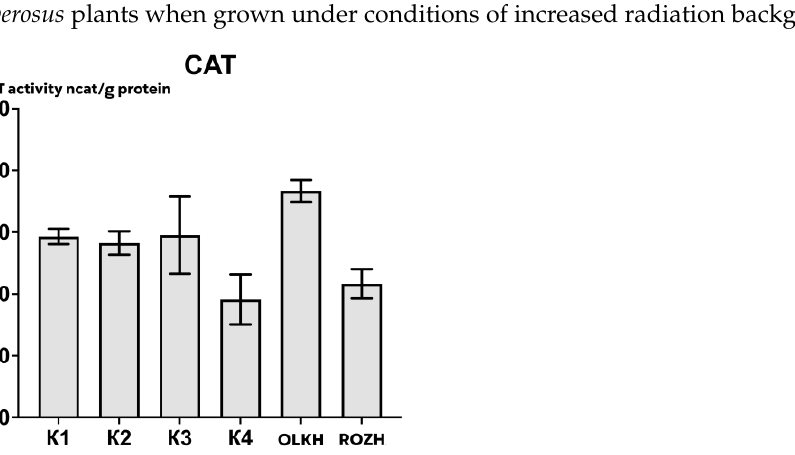
Figure 2. CAT activity in tubers of H. tuberosus growing in contaminated areas and in areas without contamination.